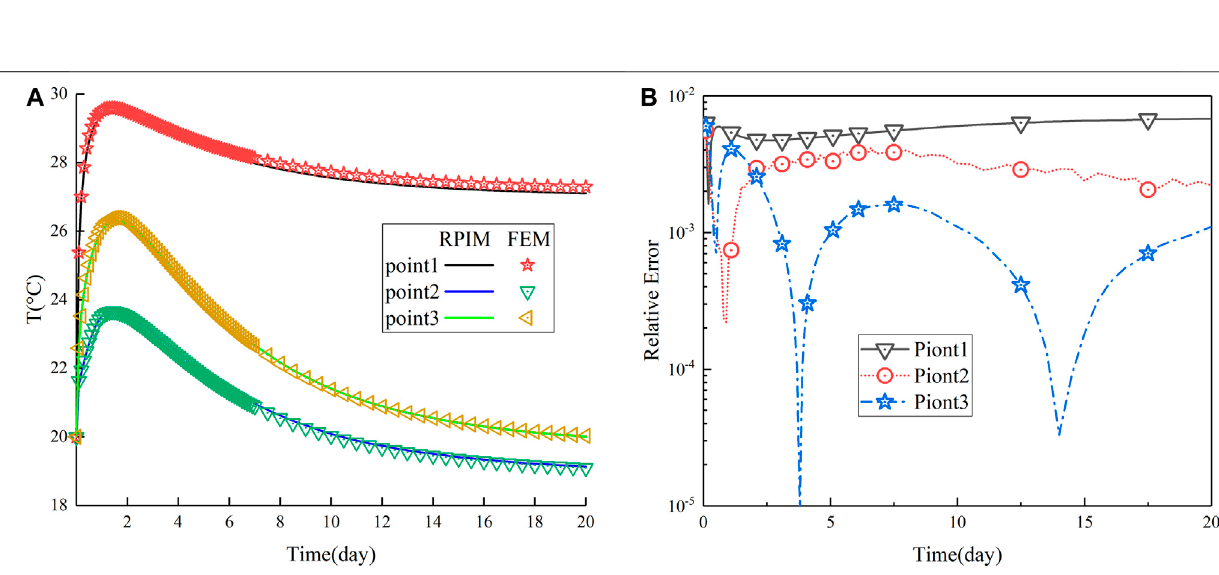
Frontiers in Physics |